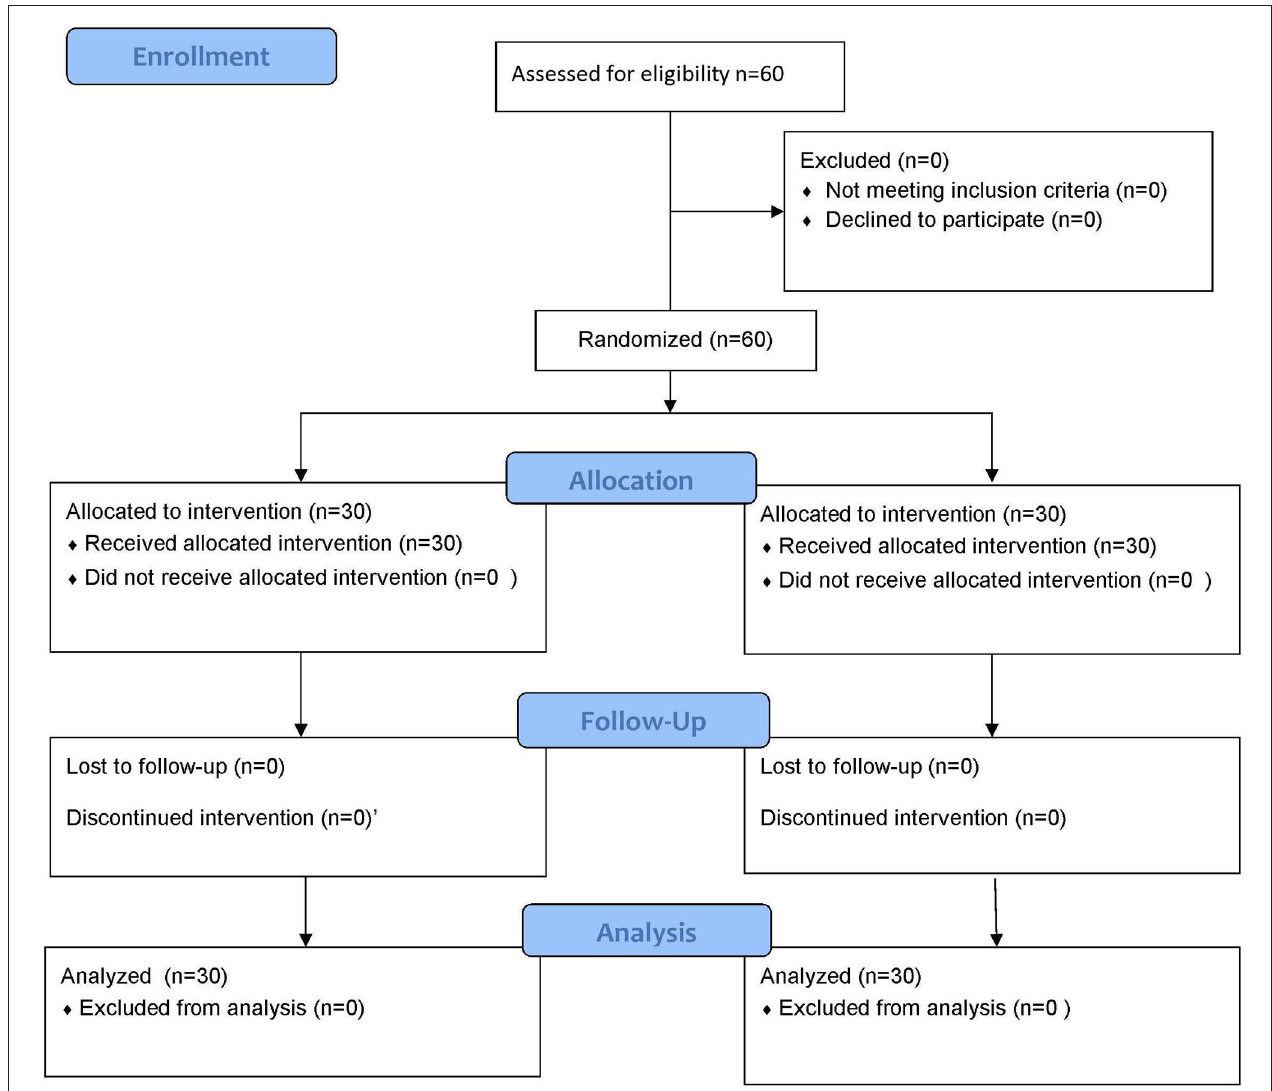
FIGURE 5 | Demonstrates the flow diagram for patient recruitment and